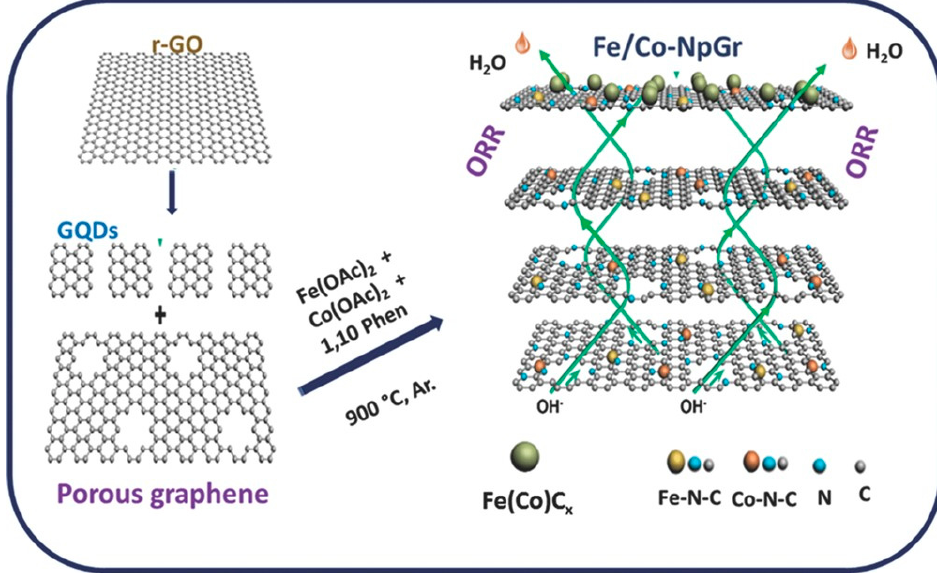
Figure 3. The scheme of the preparation of active Fe/Co-NpGr representing facile ion transport attainable within the hybrids through the holes in the porous graphene, which may enhance the accessibility of the active sites and lead to improved oxygen reduction reaction (ORR) activity, reproduced with permission from [31]. Copyright Wiley,